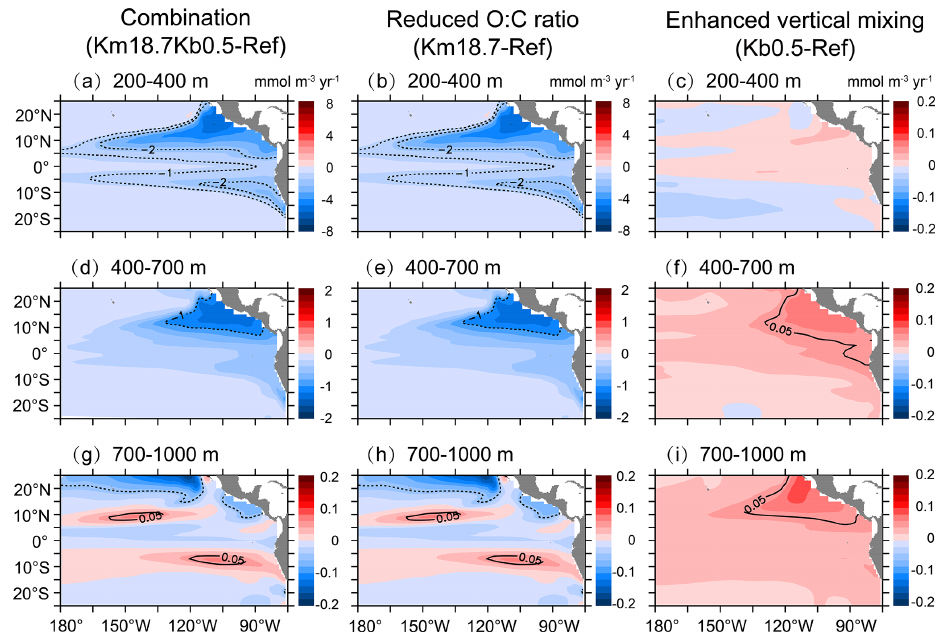
Figure 8. Changes in biological consumption over (a, b, c) 200–400m, (d, e, f) 400–700m, and (g, h, i) 700–1000m due to the combination of a reduced O : C utilization ratio and an enhanced vertical mixing ( a, d, g ), a reduced O : C utilization ratio ( b, e, h ), and an enhanced vertical mixing ( c, f, i